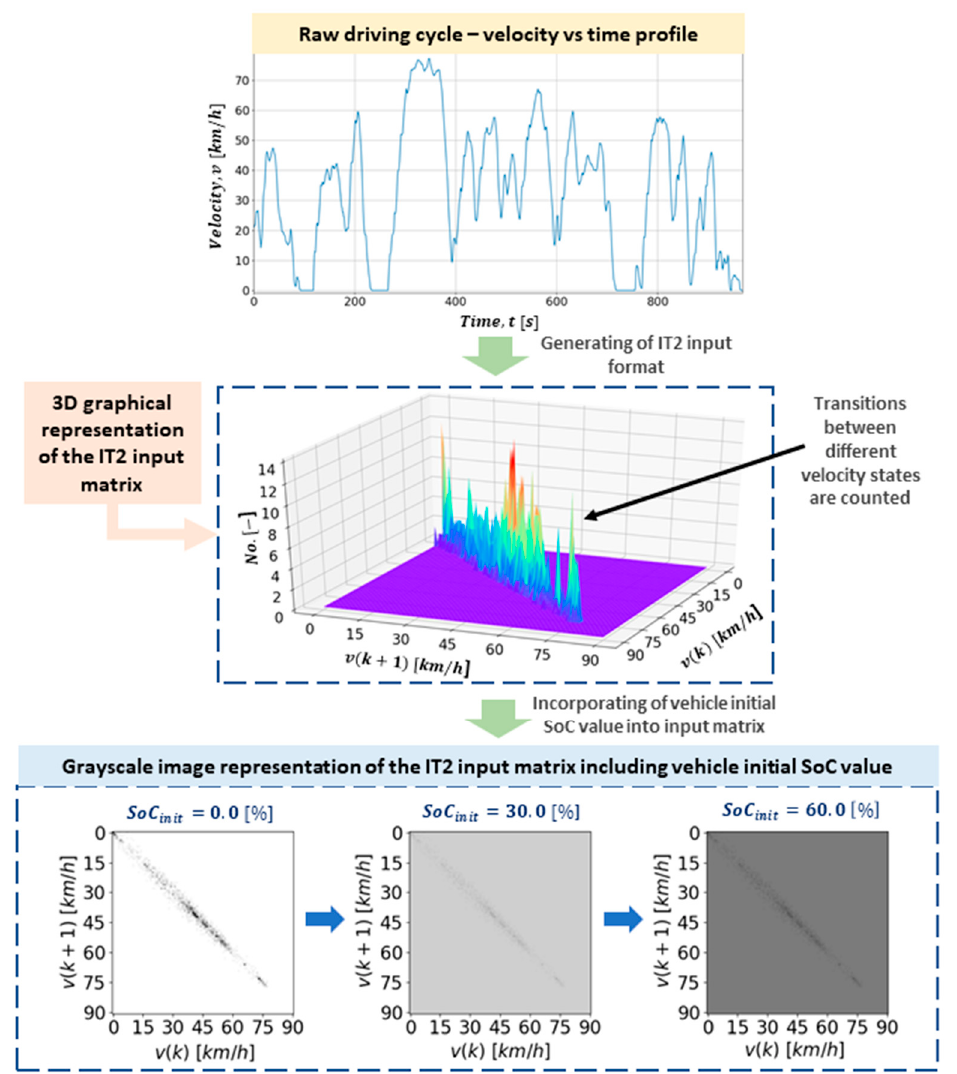
Figure 2. Illustration of process of generating NN input type IT2.